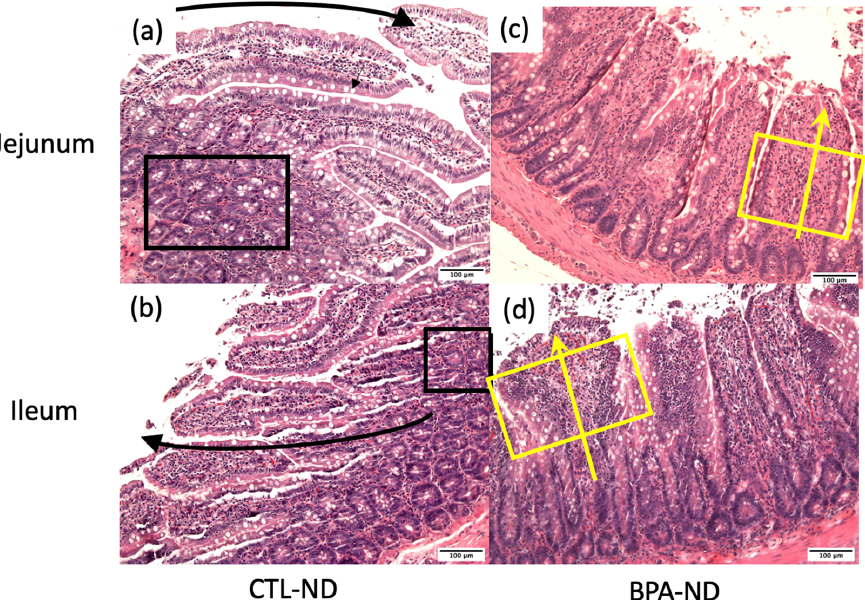
Figure 3. Representative images of the jejunum and ileum sections from adult offspring on a normal diet, stained with H&E (scale bars = 100 μ m). ( a , b ) Normal jejunum and ileum mucosa in control offspring on a normal diet, respectively. Black curved arrows indicate long and finger-like projec- tion of villi, while black boxes show normal crypt size. ( c , d ) Flattening of the jejunum and ileum villi in BPA offspring on a normal diet were focal. Yellow arrows indicate shortened villi, whereas yellow boxes indicate broadened villi. Alterations were not consistent throughout one section and across one group and hence considered non-significant (10× magnification, n = 6/group) . Figure 4. Representative images of the jejunum and ileum sections from adult offspring on the trans fat diet, stained with H&E (scale bars = 100 μ m). ( a , b ) Elongated crypts (yellow box) and blunted villi were found in control offspring on trans fat diet. ( c , d ) Focal broadening and shortening of villi and mucosal necrosis were observed in jejunum and ileum of BPA offspring on a trans fat diet.